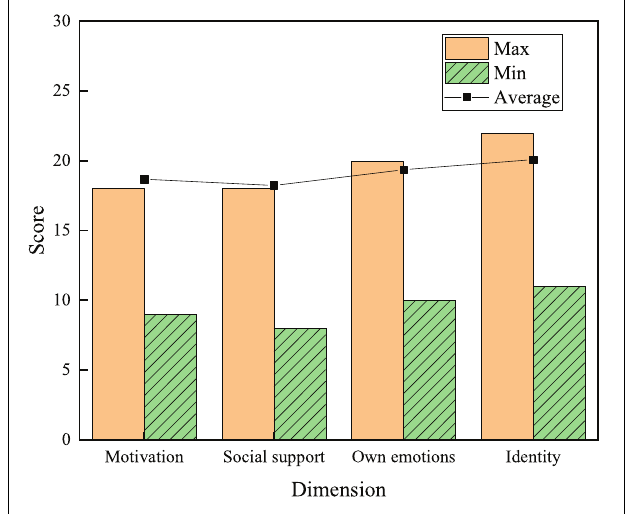
FIGURE 6 | Scores of psychological factors.